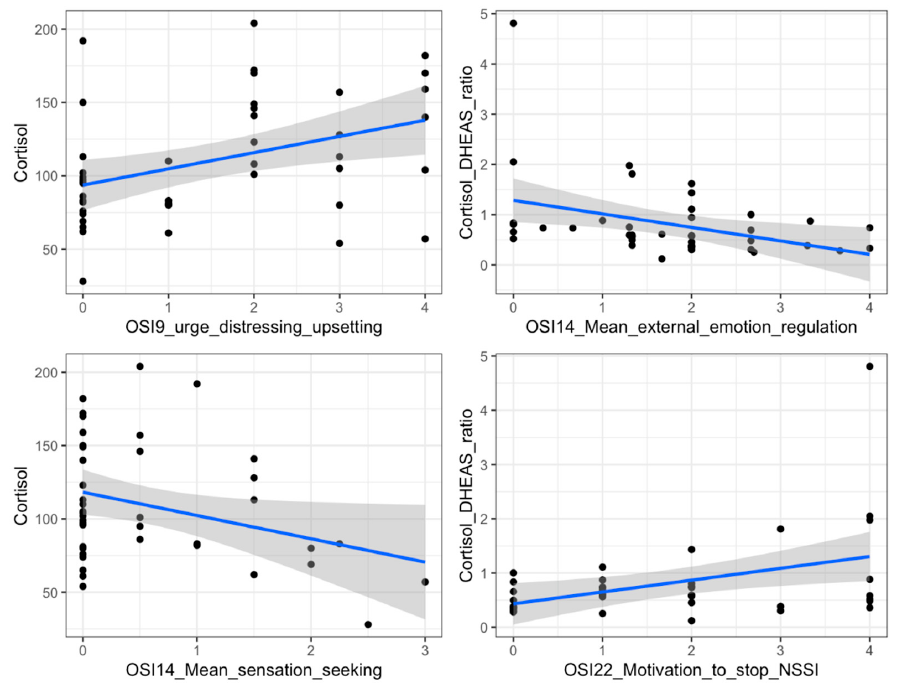
Figure 1. Correlation scatter plots: in the ( upper left ) plot, the correlation between cortisol and OSI no. 9 (“Urge”) item score “Urge distressing/upsetting”; in the ( upper right ) plot, the correlation between the cortisol/DHEA-S ratio and OSI no. 14 item score “Mean external emotion regulation”; in the ( lower left ) plot, the correlation between cortisol and OSI no. 14 (“Mean sensation seeking”); in the ( lower right ) plot, the correlation between cortisol/DHEA-S ratio and OSI no. 22 item score “Motivation to stop NSSI”.